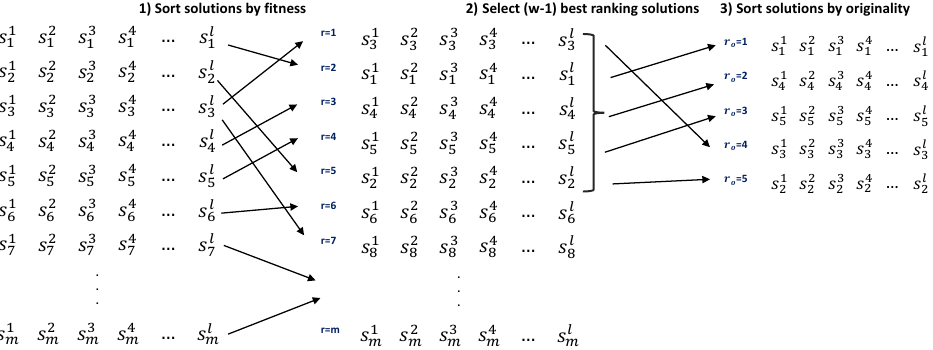
Figure 5. Steps of the process of selection and ranking of solutions for the pheromone reinforcement (where s i represents a solution component of the tour of length l of the k -th k